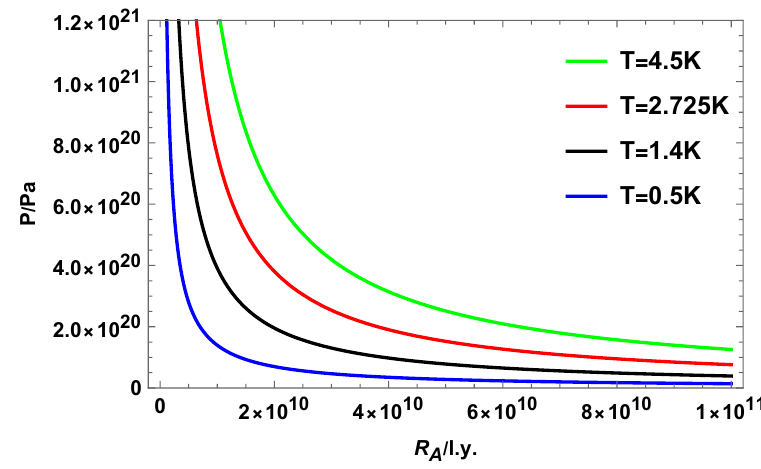
Figure 1 . Isothermal curves of FRW universe in the P - R A phase diagram, which imply no P - V phase